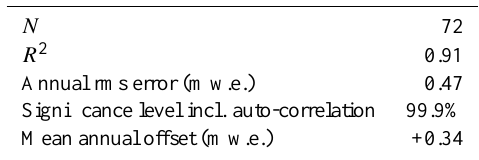
Table 4. Error estimation regarding the HadCM3 data based surface mass balance time series.